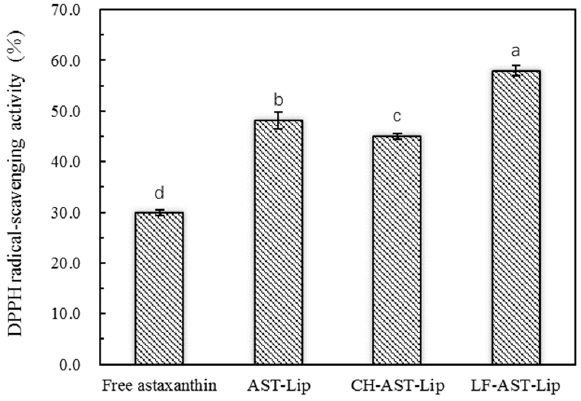
Figure 5. DPPH free radical scavenging rate of different samples, different lowercase letters on the column chart indicate significant differences between groups ( p < 0.05).